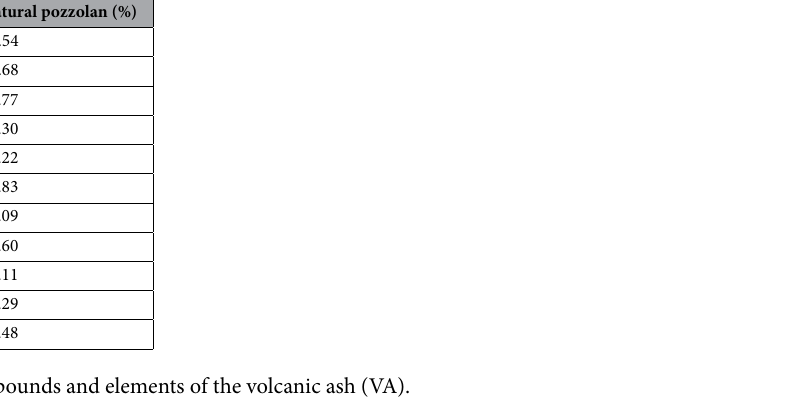
Table 3. Chemical compounds and elements of the volcanic ash